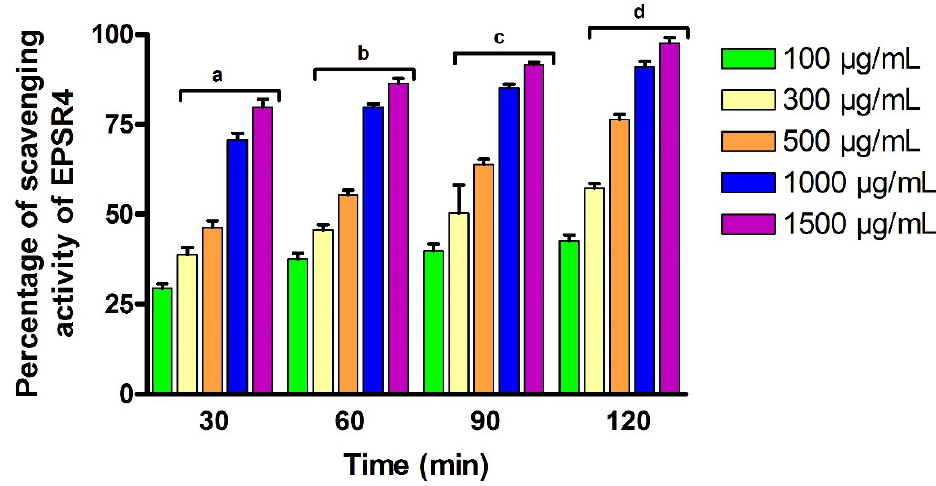
Figure 8. The activity of EPSR4 to scavenge the free radical of DPPH at different time intervals. Data are presented as mean ± SD. a p < 0.05 versus concentration of 100 µ g/mL in 30 min, b p < 0.05 versus concentration of 100 µ g/mL in 60 min, c p < 0.05 versus concentration of 100 µ g/mL in 90 min, d p < 0.05 versus concentration of 100 µ g/mL in 120 min.